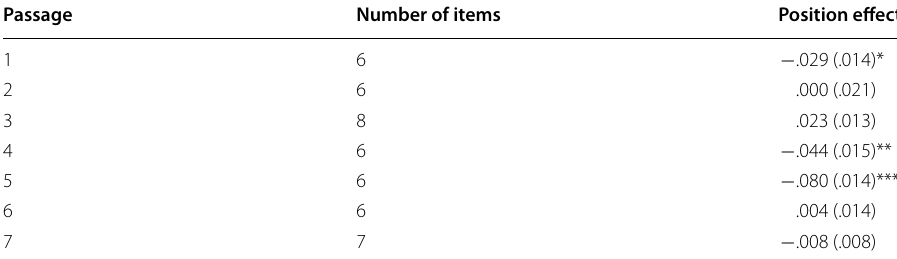
Table 4 Summary of estimated passage position effects